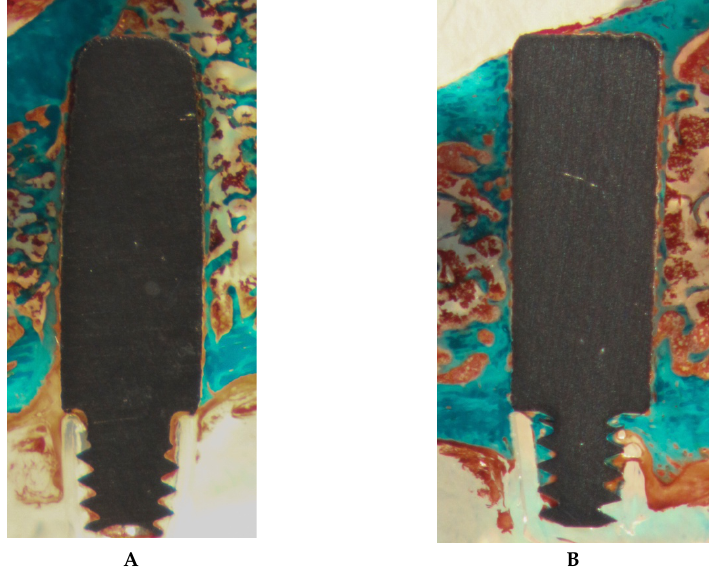
Figure 6. Exemplary Masson–Goldner stains of cast ( A ) and standard ( B ) Ti6l4V implants after 12 weeks. Mature osseous tissue is stained blue, while newly formed bone as well as connective tissue appears red. In both sections, a thin layer of mature bone covers the implant surface.